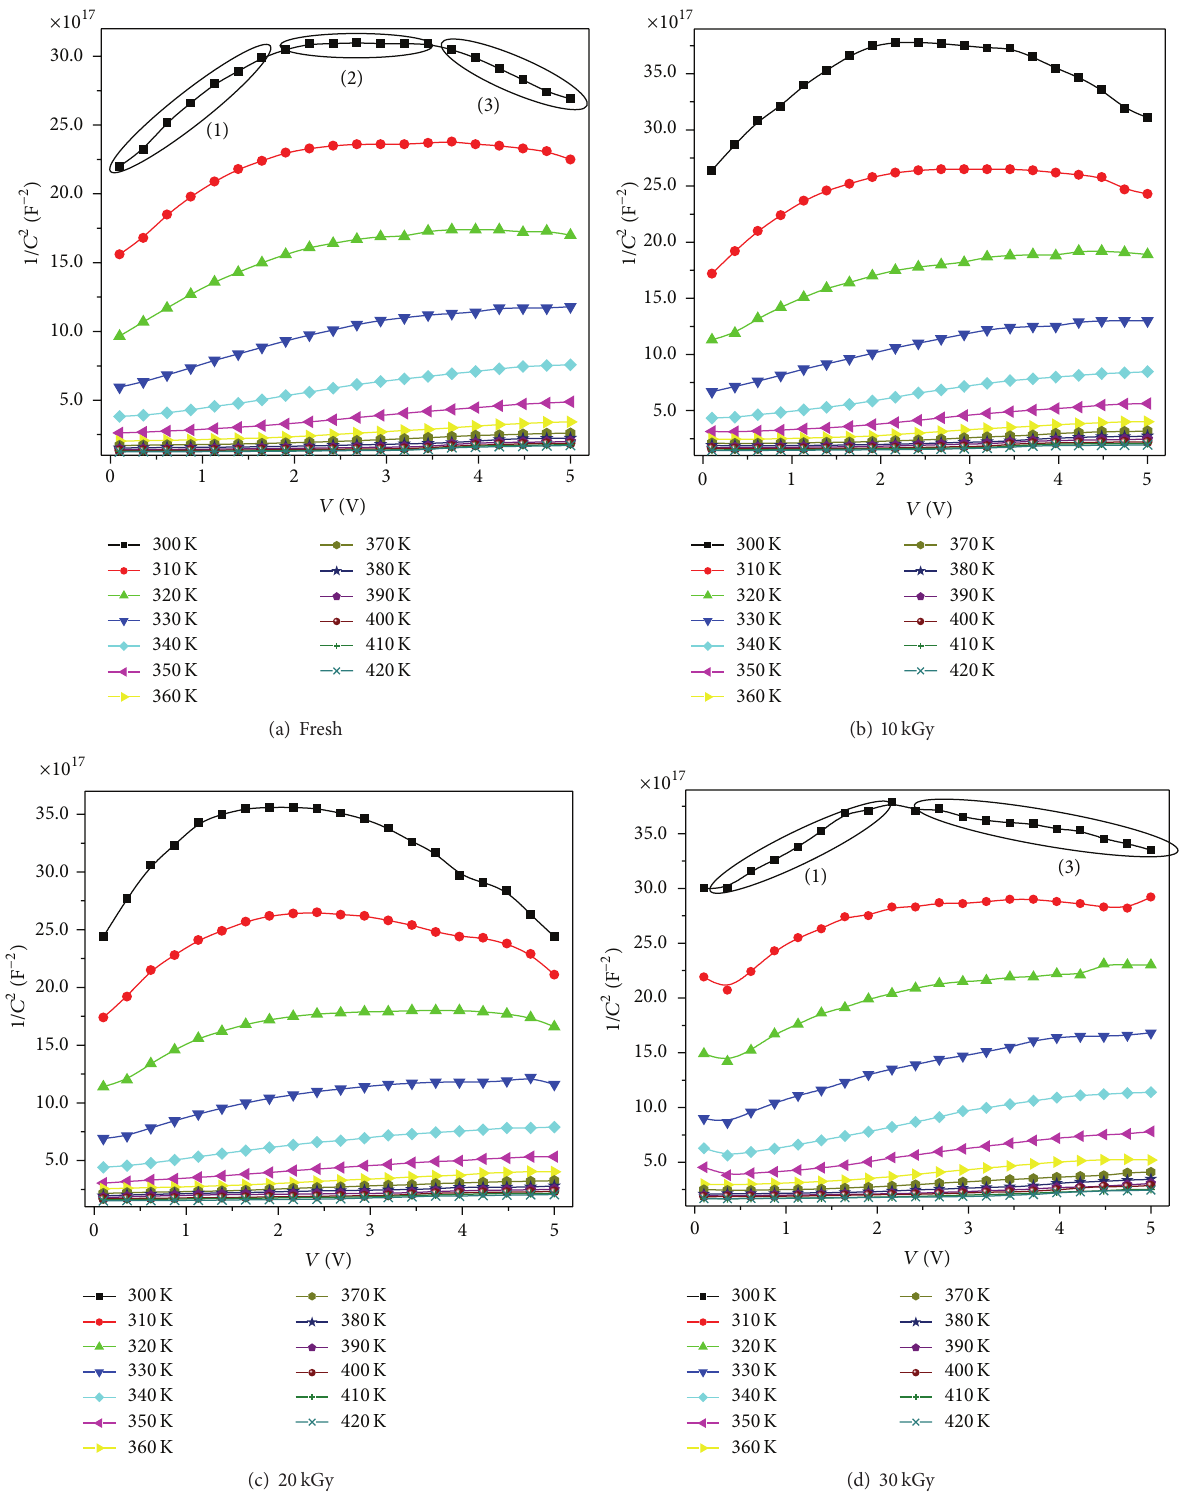
Figure 5: Temperature dependence of Mott-Schottky plot for the investigated CdS/Si heterojunction at different temperature (a) before and (b–d) after 𝛾 -irradiation with different